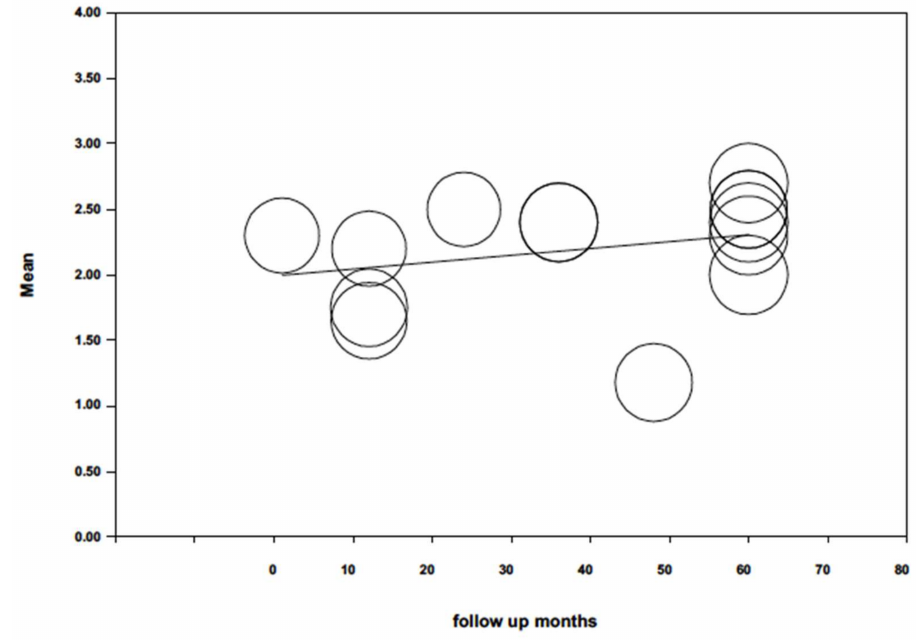
Figure 8. Scatter plot of mean periodontal probing depth meta-regression over time.